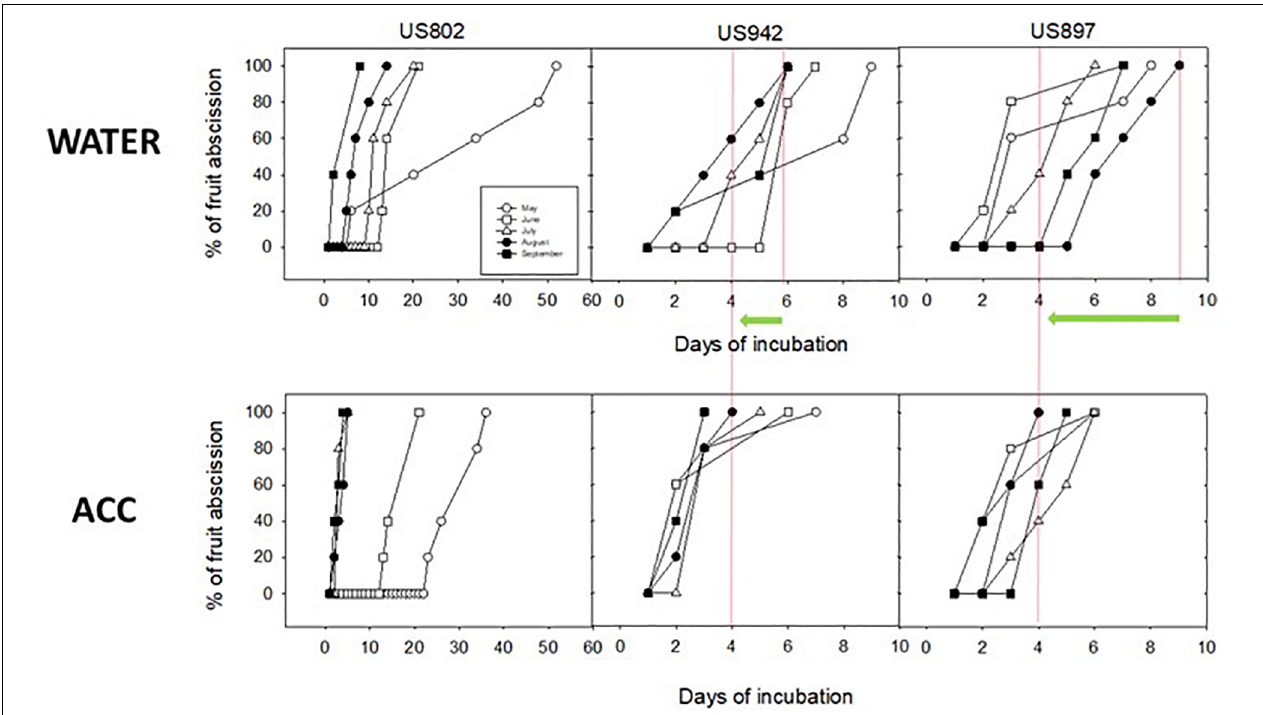
FIGURE 9 | Abscission dynamics of fruit from US-802, US-897, and US-942 harvested on May, June, July, August, and September, and incubated in vitro in the absence (lower panels, water control) or presence (upper panels) of the ethylene precursor ACC (1-aminocyclopropane-l-carboxylic acid). The 3 panels are aligned to allow comparisons of abscission rate. Green arrows and red lines highlight the advancement in fruit abscission rate for